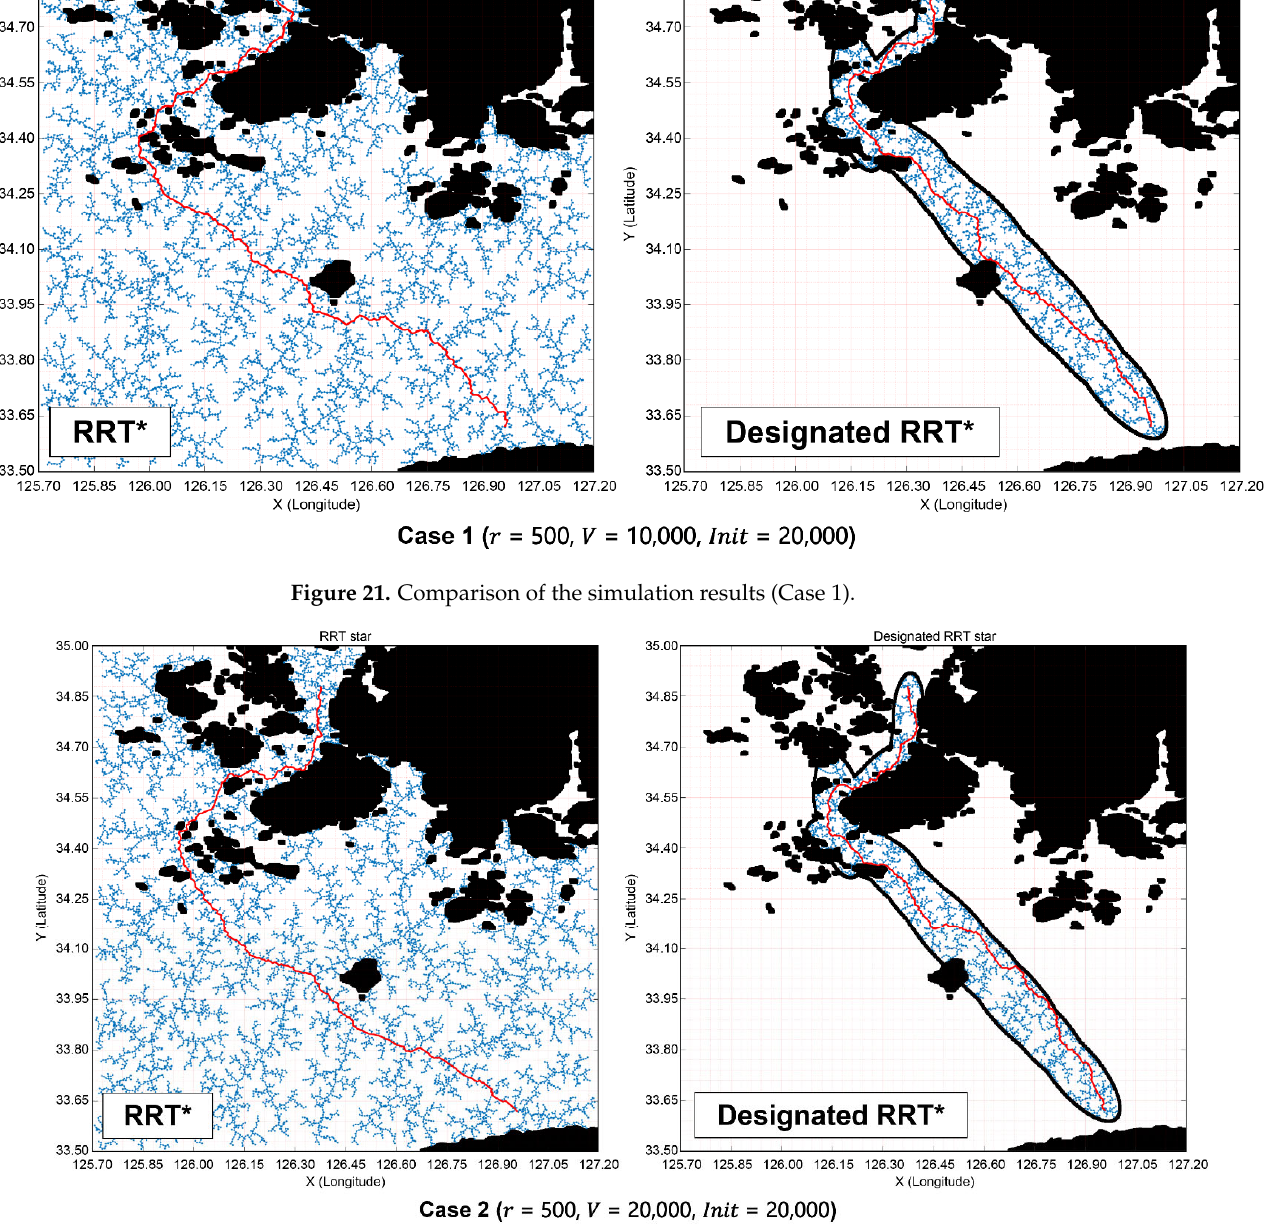
Figure 22. Comparison of the simulation results (Case